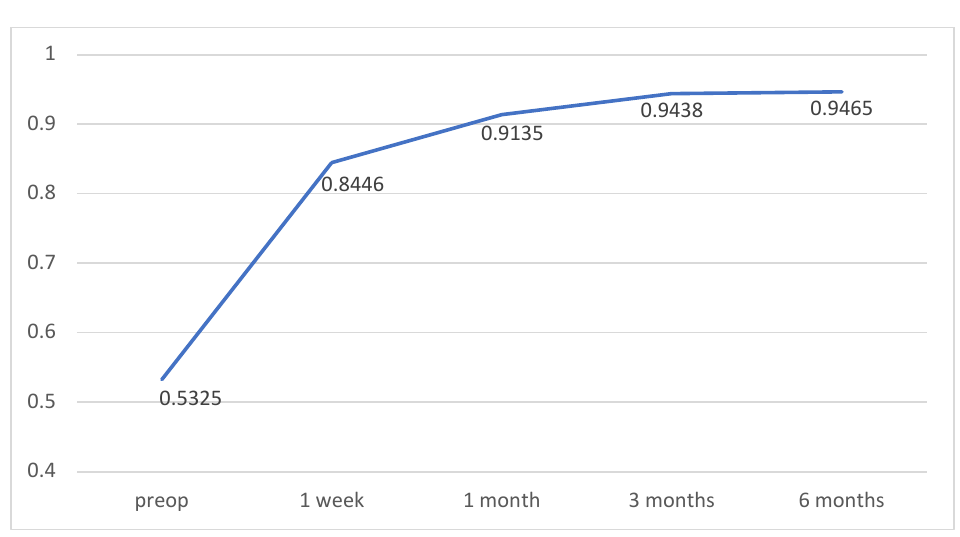
Figure 8. Temporal evolution of mean best corrected visual acuity (BCVA).